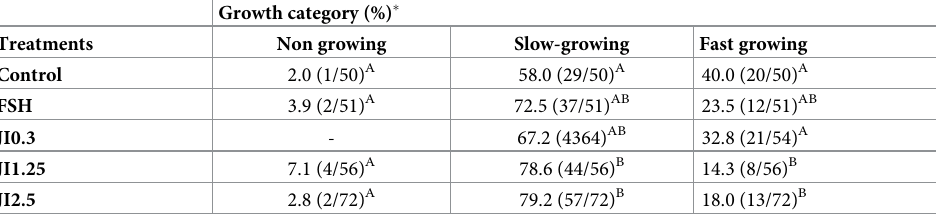
Table 3. Percentage of secondary follicles within a growth category at different time point (D0, D6, D12, D18) in MEM + (Control), FSH or in J . insularis 0.3, 1.25 or 2.5 mg/mL (JI0.3, JI1.25 or JI2.5 respectively).